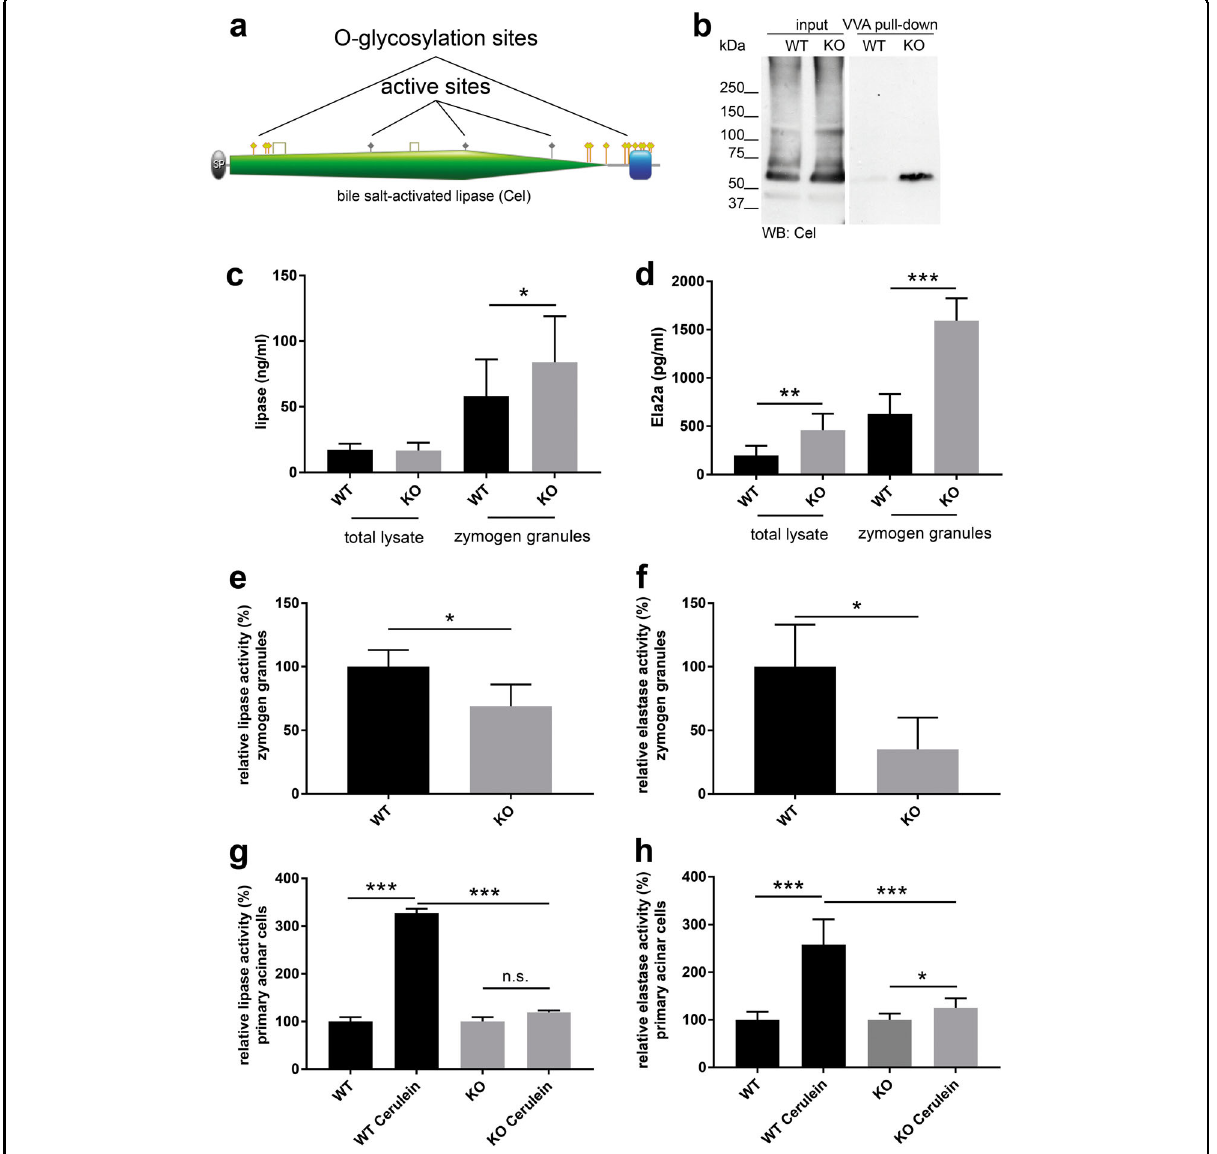
Fig. 2 Cosmc-dependent O-GalNAc glycosylation affects pancreatic lipase and elastase enzyme function as well as exocrine pancreas secretion. a Scheme of bile salt-activated lipase (Cel) protein domains (SP, signal peptide; carboxylesterase, type B, green; PEST domain, blue; O- GalNAc glycosylation sites, yellow; active sites, gray). b Representative WB of VVA pull-down from WT and Cosmc- KO pancreatic lysates and Cel- speci fi c antibody for detection. Note : Distinct Cel protein bands were robustly detected in pull-downs from KO tissue. c Absolute quanti fi cation of lipase in total lysates and zymogen granule lysates from WT and Cosmc- KO mice ( n = 18). Total lysates display equal amounts of lipase ( P = 0.748), whereas elevated levels are detected in Cosmc- KO zymogen granules ( P = 0.023). d Absolute quanti fi cation of elastase (Ela2a) in total and zymogen granule lysates from WT and Cosmc- KO mice ( n = 18). Lysates derived from Cosmc KO display signi fi cantly elevated elastase. ( e + f ) Relative lipase and elastase activities in zymogen granule lysates from WT and Cosmc- KO mice ( n = 4) using 4-MU substrates reveal decreased activities in KO. ( g + h ) Analysis of lipase and elastase activities in response to cerulein stimulation of WT and Cosmc- KO primary pancreatic acinar cells. Cerulein- induced lipase and elastase secretion is detectable in WT cells ( P = 0.0001) and is attenuated in Cosmc- KO mice ( P = 0.611 and P = 0.04). Relative difference in stimulated lipase activity is P =